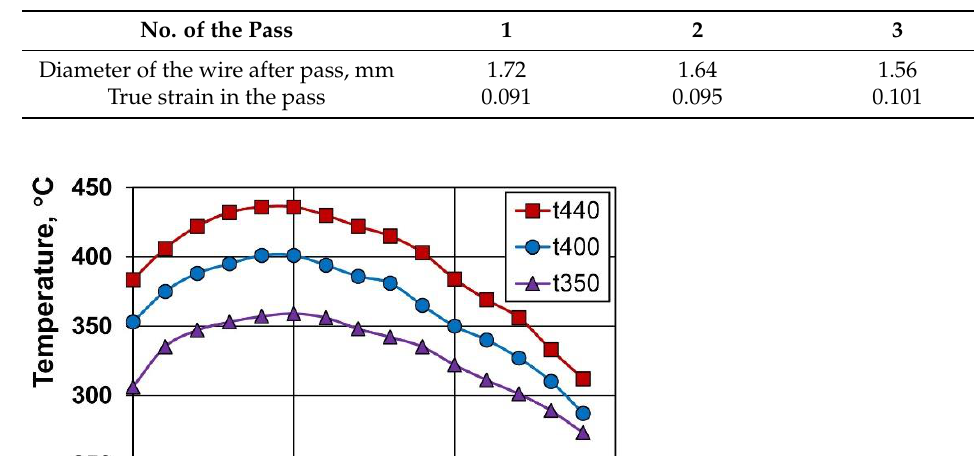
Figure 1. Technology of wire production: ( a ) hot-drawing processes used in the experiment: 1 — wire; 2 — drawing die; 3 — heating device; ( b ) wires, obtained by extrusion (1), hot drawing in